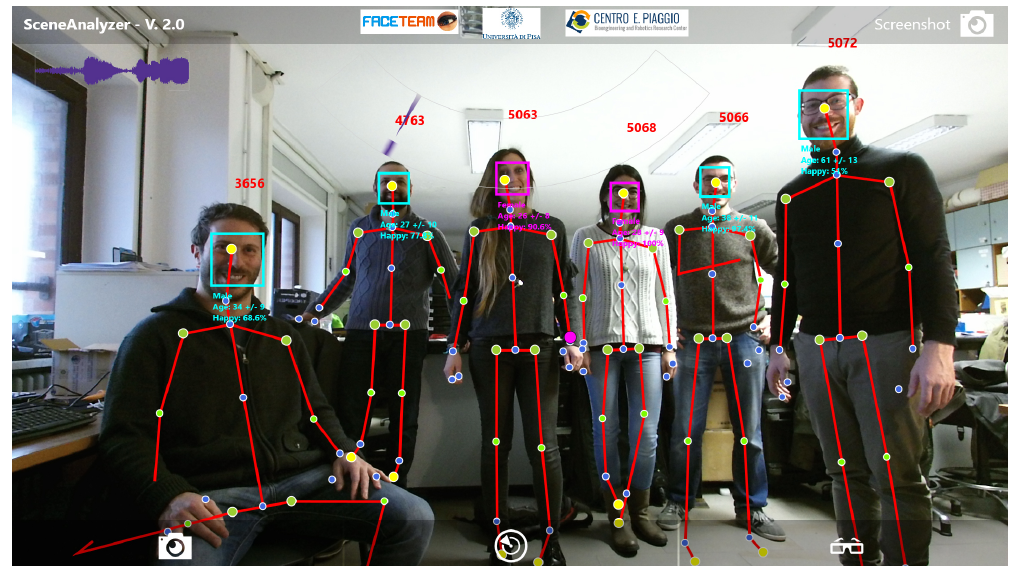
Figure 1. Screenshot of the SA (Scene Analyzer) visualiser in a case of crowded scenario.